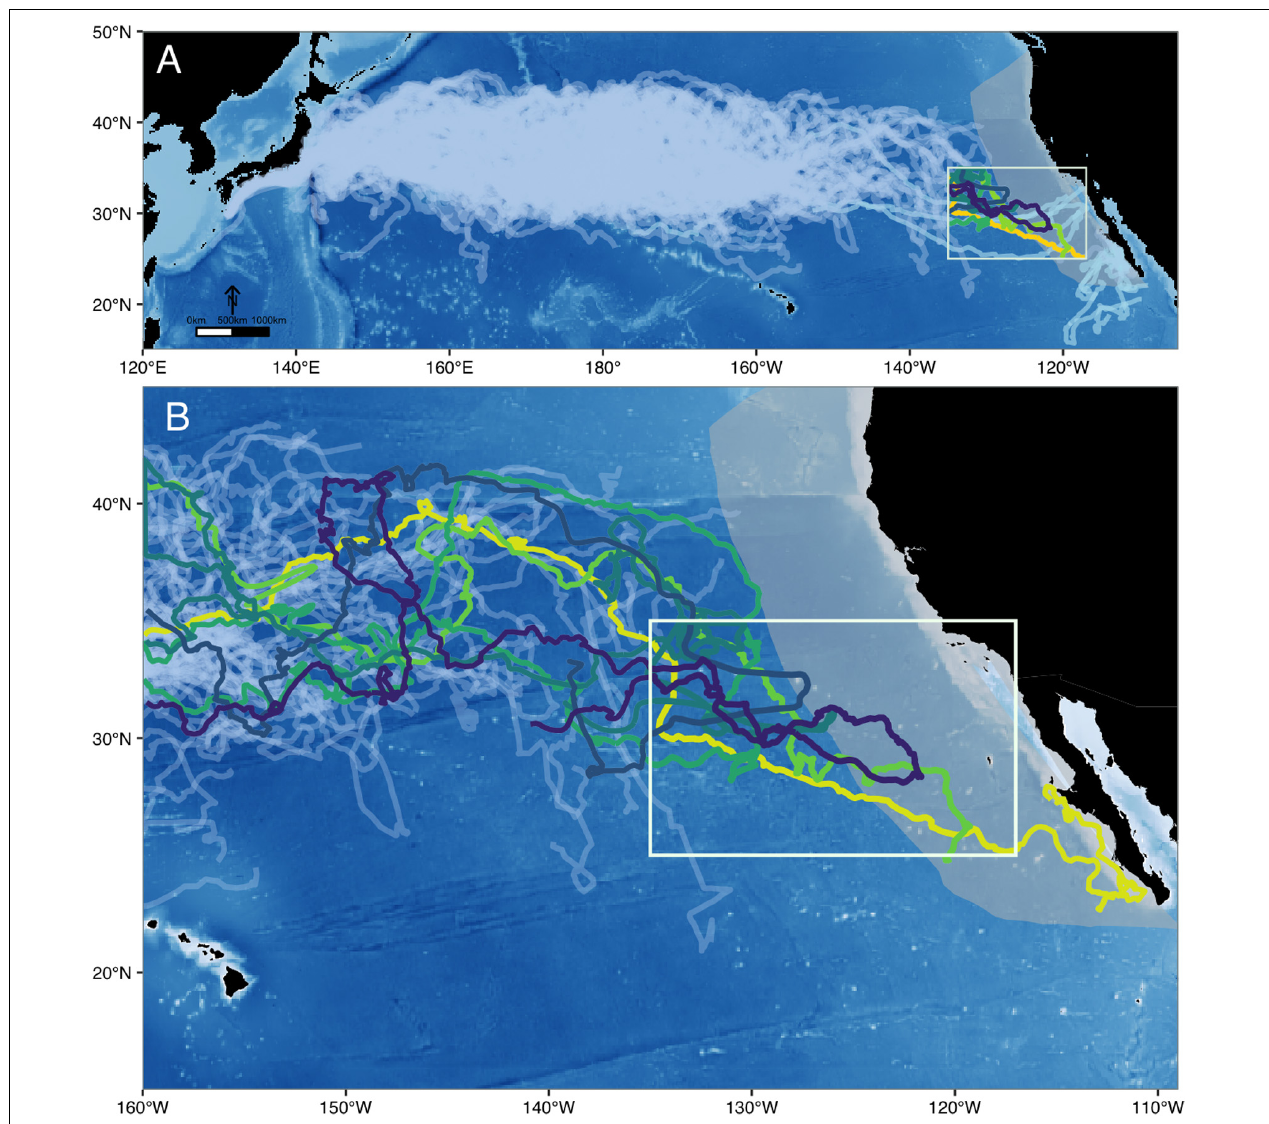
FIGURE 1 | State-space modeled distribution of (A) 231 electronically tagged juvenile loggerhead sea turtles across the North Pacific Ocean (1997 – 2013), deployed off Japan and in the Central North Pacific (light gray). CCLME region shown in gray. While individuals released from the North American coast (light blue) were not included in the study because they represent a larger age-size class, they are shown here to characterize the full habitat use of individuals from this population. (B) The eastern North Pacific study region, utilized by the 6 individuals that migrated from the Central North Pacific towards the North American coast study area (white